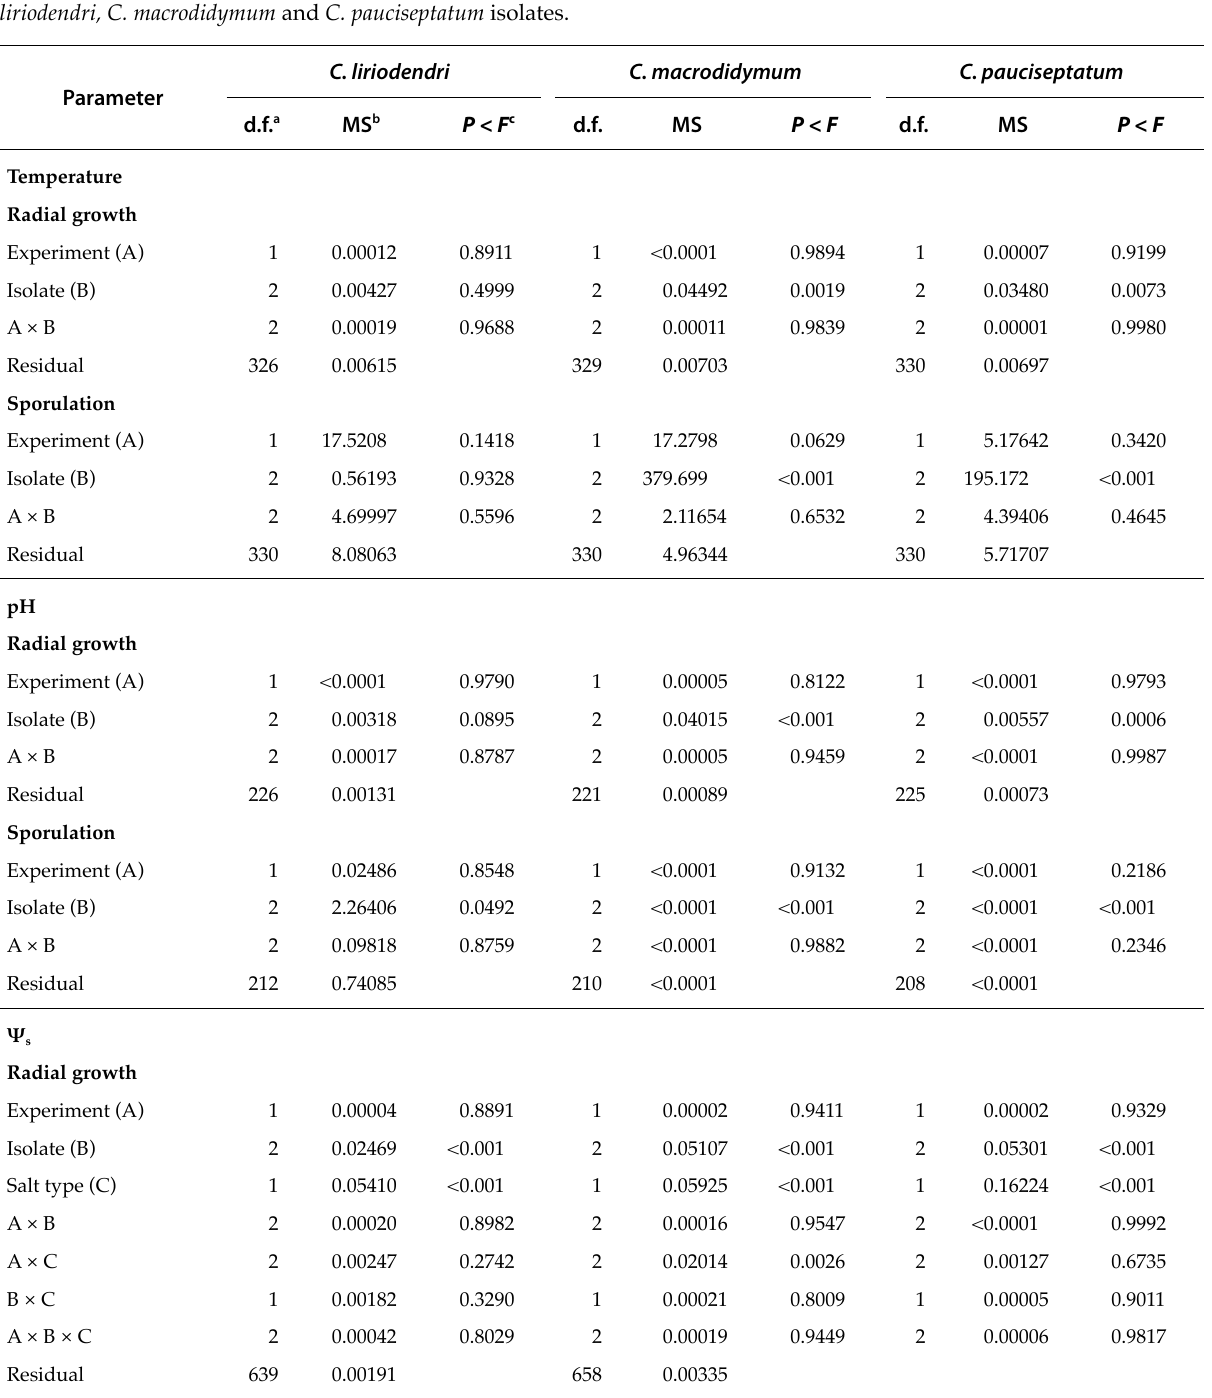
s on radial growth and sporulation of Cylindrocarpon